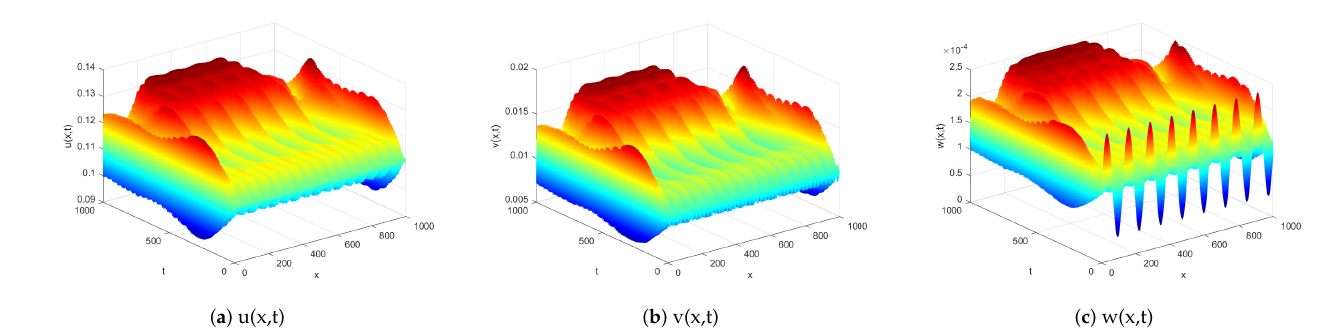
Figure 8. ( u p ( t ), v p ( t ), w p ( t )) becomes diffusion-induced unstable, and the emerging spatiotemporal patterns can be